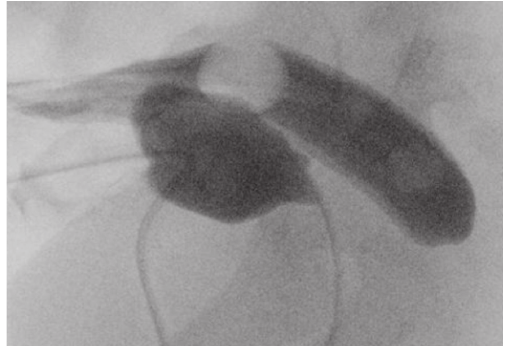
Figure 4: A combination of cologram and contrast in the urinary bladder excluded a fistula.